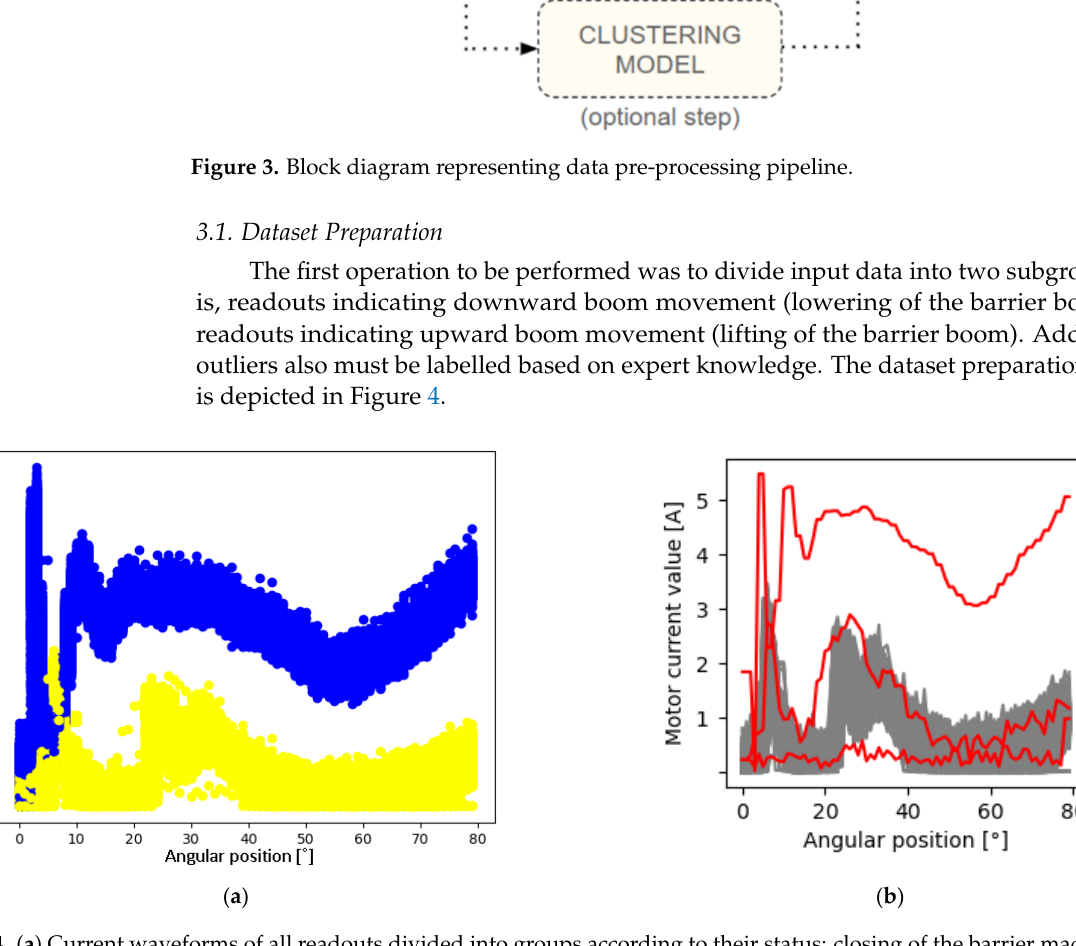
Figure 4. ( a ) Current waveforms of all readouts divided into groups according to their status: closing of the barrier machine (yellow) and opening the barrier machine (blue); ( b ) Correct current readouts (grey) and outliers (red).